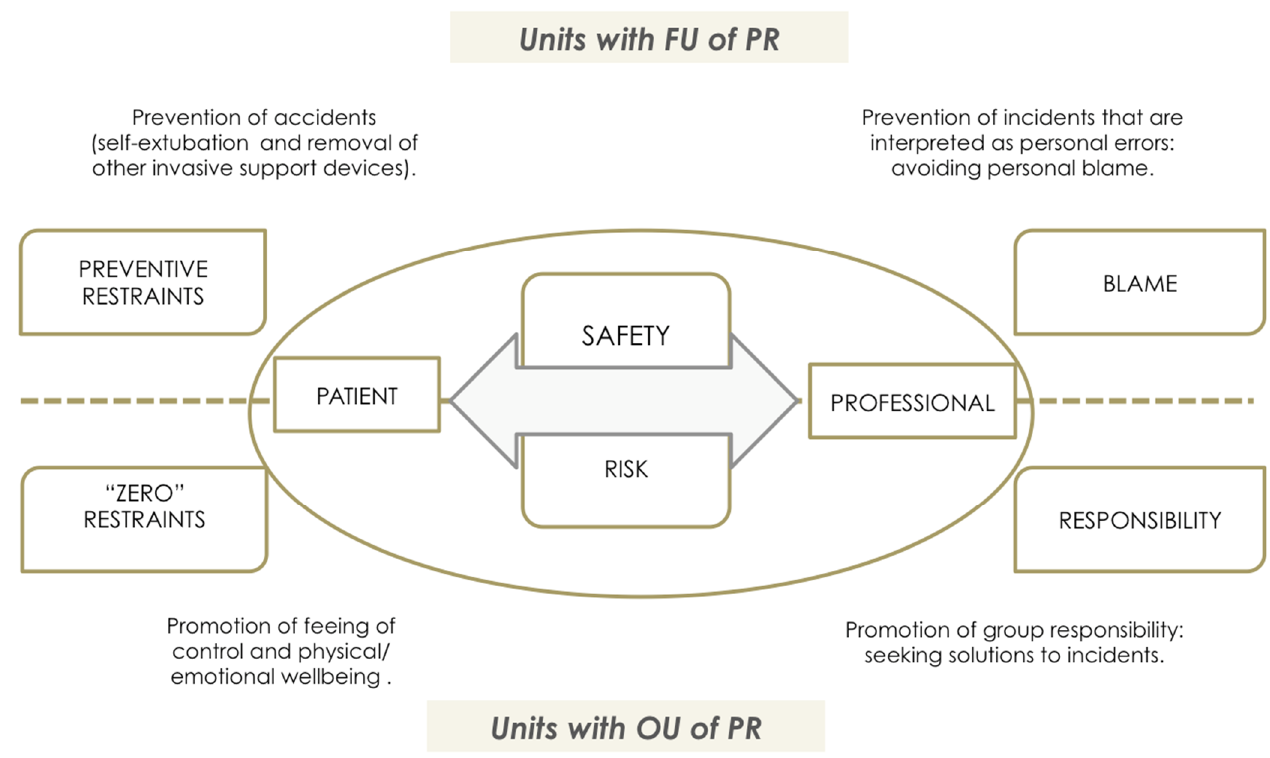
Figure 7. Concept of safety and risk in relation to use of physical restraints. Abbreviations: PR: physical restraint; OU: occasional/individualized use; FU: frequent/systematic use.